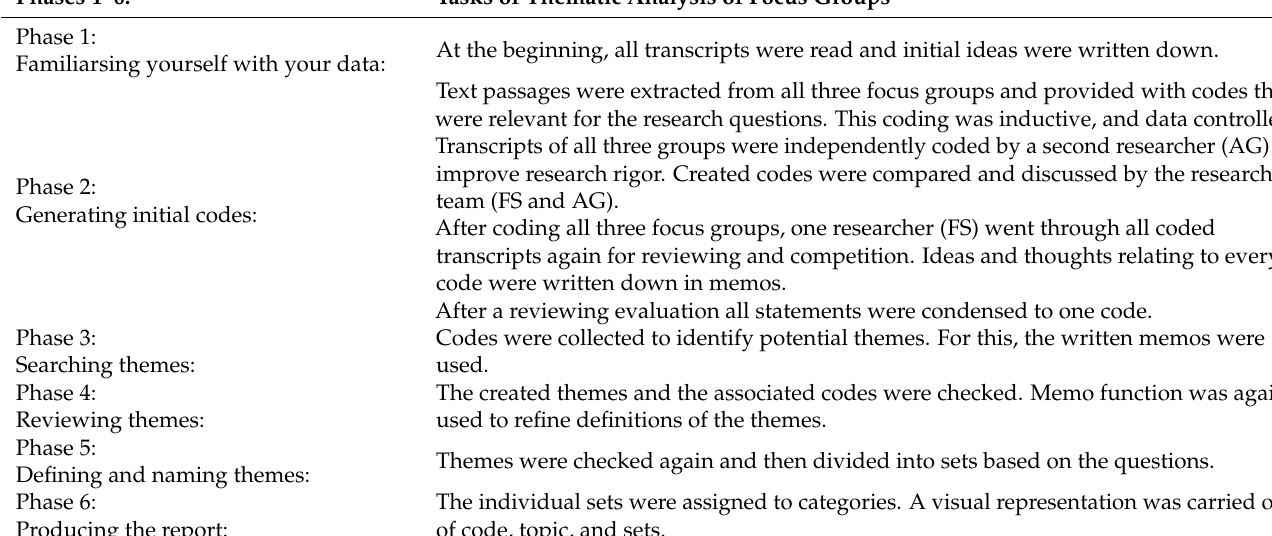
Table 2. Six phases of a thematic analysis of focus groups with health care professionals based on Braun and Clarke (own presentation) [30]. Tasks of Thematic Analysis of Focus